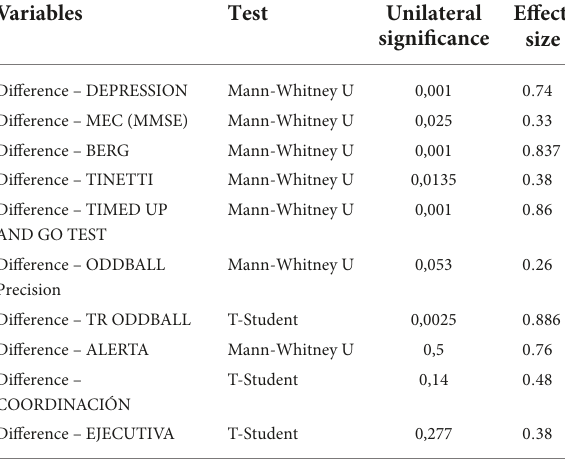
TABLE 5 Differences in both groups. Reference: own